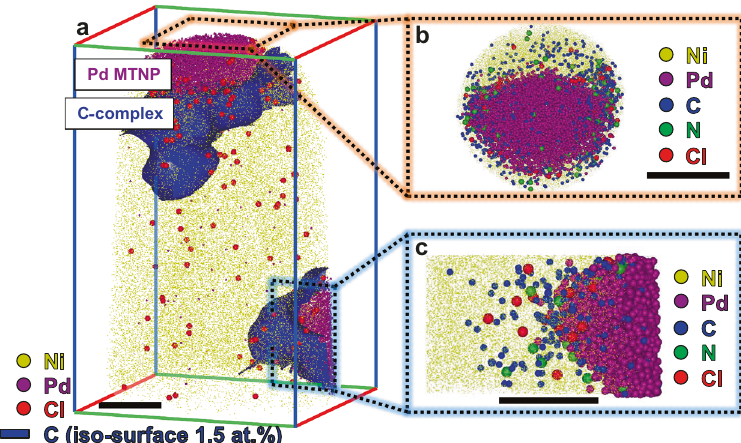
Fig. 2 Atom probe tomography (APT) reconstruction of Pd multiple-twinned NPs (MTNPs), synthesized by adding Br anions, embedded in Ni. a Three-dimensional atom map of Pd atoms and iso-concentration (1.5 at.%) surfaces of C. b , c Slices viewed along the Pd MTNPs. (Scale bars: 10